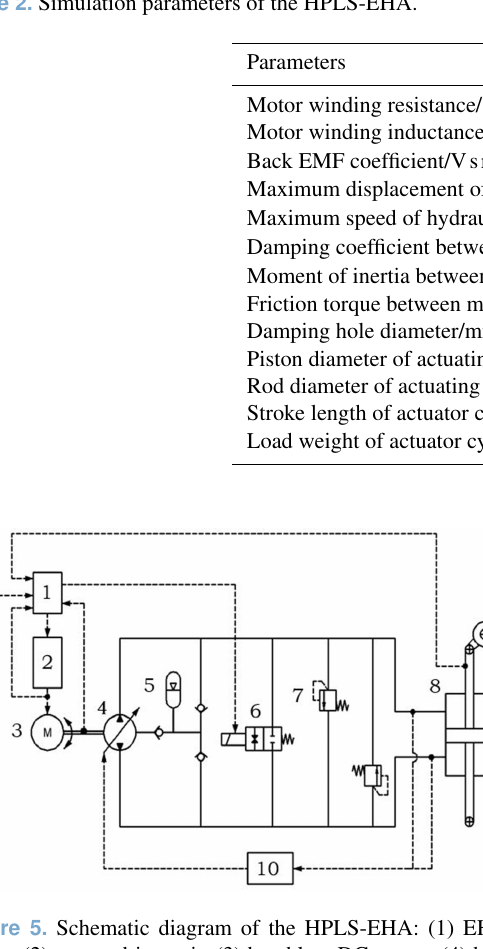
Table 2. Simulation parameters of the HPLS-EHA.